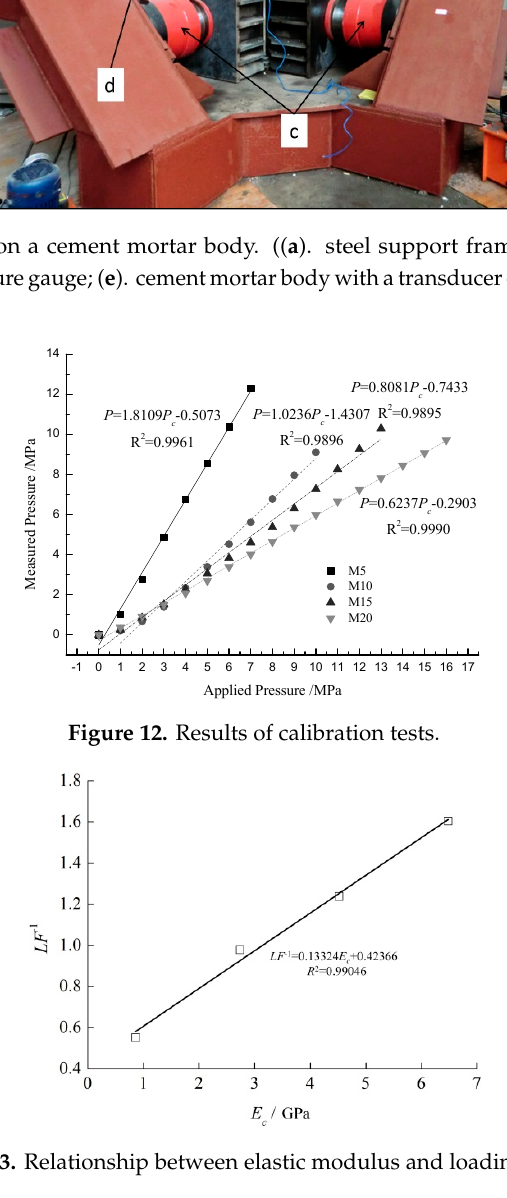
Figure 14. Frequency change with time of buried transducers in PDS No. 1 coal mine. According to Equation (4), the variation in the compressive stress output from the transducer with test time can be obtained (see Figure 15). From Figure 15, it can be observed that the measured stresses increase rapidly during the first few days and gradually become stable when the time of the test exceeded 140 days. The characteristics of stress curves show are similar to classic creep curves for rock masses where the transient creep stage and steady-state creep stage are contained. It was also found that the time for the stress become stable was much longer than the relaxation time obtained from the creep test, which generally is in hundreds of hours. This indicated that the rheological process of the rock mass is much slower than that of the rock specimens. Table 3. Information for transducers embedded in PDS No. 1 coal mine. Transducer No.